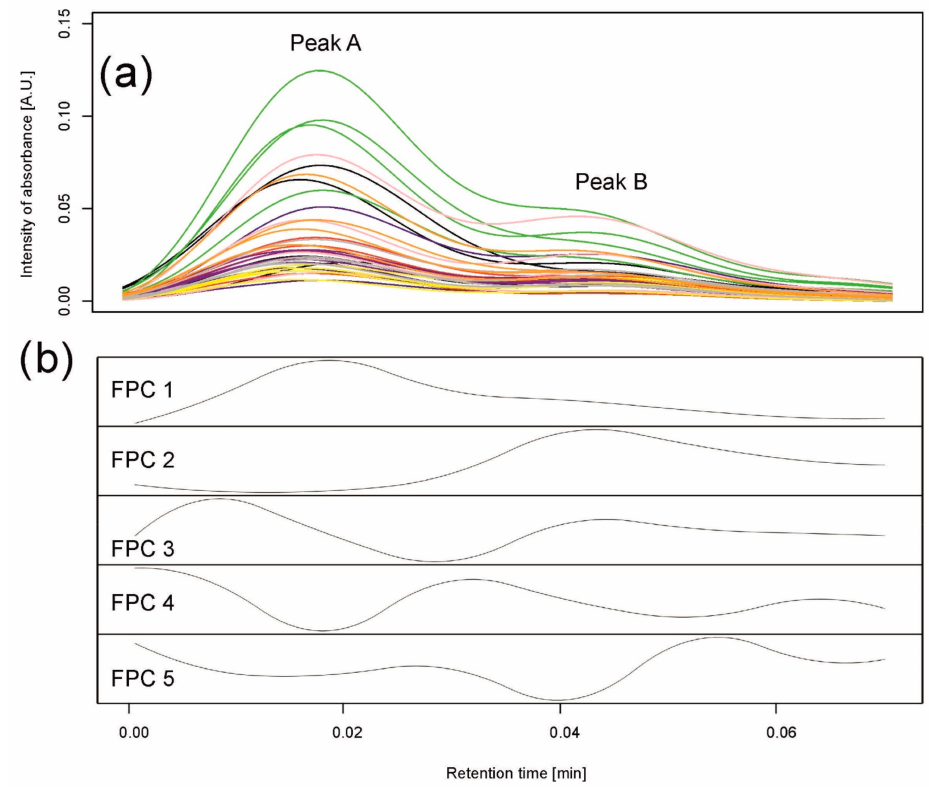
Figure 7. Data analysis for peak observed on the 6th day of control for wavelength 330 nm. ( a ) Observed chromatograms. Different colors indicate varieties: black—Maresi; red—Lubuski; blue—Georgia; green—Harmal; pink—Cam/B1/CI; purple—MDingo; yellow—Morex; gray—Sebastian; and orange—Stratus. ( b ) First five eigenfunctions accounting for 99.98% of the total variance. Component FPC1 (97.59% of the variance) corresponds to peak A, and component FPC2 (1.77% of the variance) to peak B.